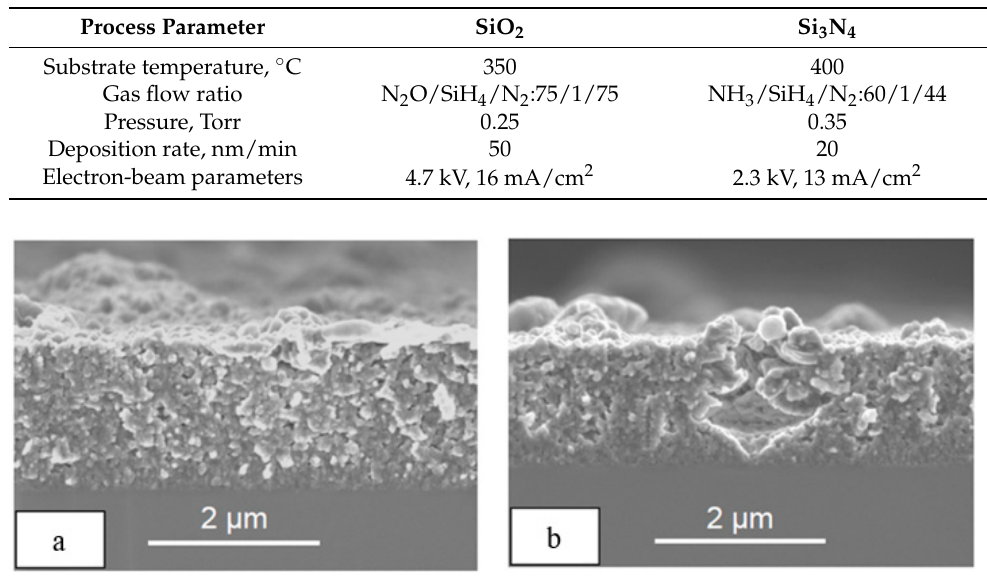
Table 1. Deposition parameters of silicon dioxide and nitride by the PECVD method.